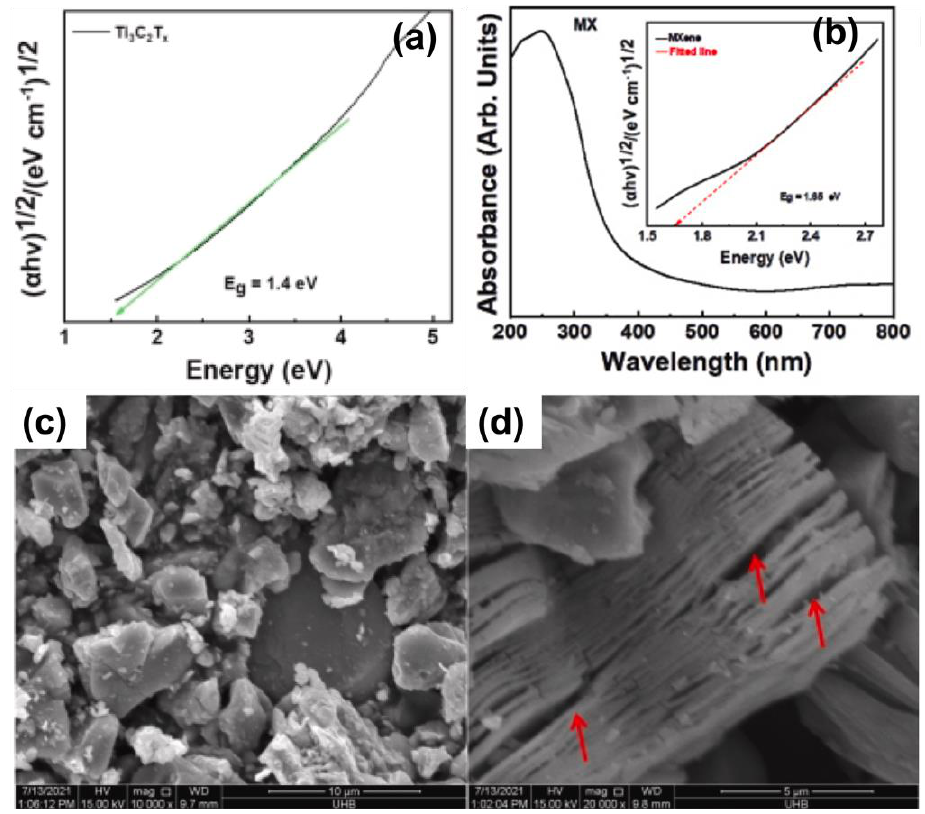
Figure 3. UV-Visible Spectrum of MXene ( a ) (Reprinted with permission from Ref. [26]. 2022 Elsevier); ( b ) (Reprinted with permission from Ref. [27]. 2021 Elsevier) and SEM images of ( c ) Ti 3 AlC 2 MAX, ( d ) MXene. (Reprinted with permission from Ref. [26]. 2022 Elsevier).